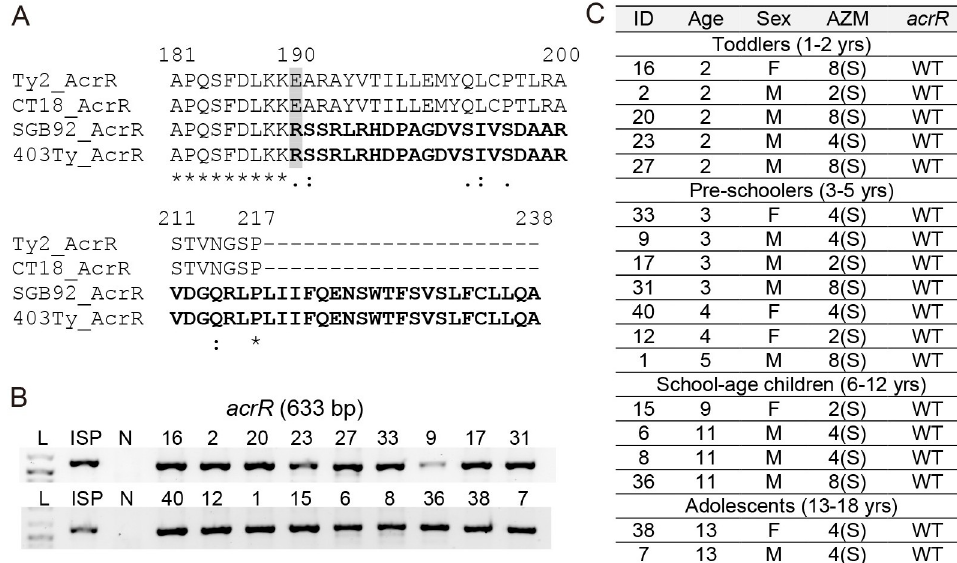
Fig 6. AcrR sequence analysis among XDR S . Typhi isolates. A , AcrR amino acid sequence comparison analysis of the latest RefSeq dataset of the fully assembled complete genome of S . Typhi (107 in total) collected from NCBI as of Feb 26, 2021. Ty2, S . Typhi Ty2 (RefSeq assembly accession: GCF_000007545.1, assembly name: ASM754v1, strain: Ty2, submitter: University of Wisconsin). CT18, S . Typhi CT18 (RefSeq assembly accession: GCF_000195995.1,